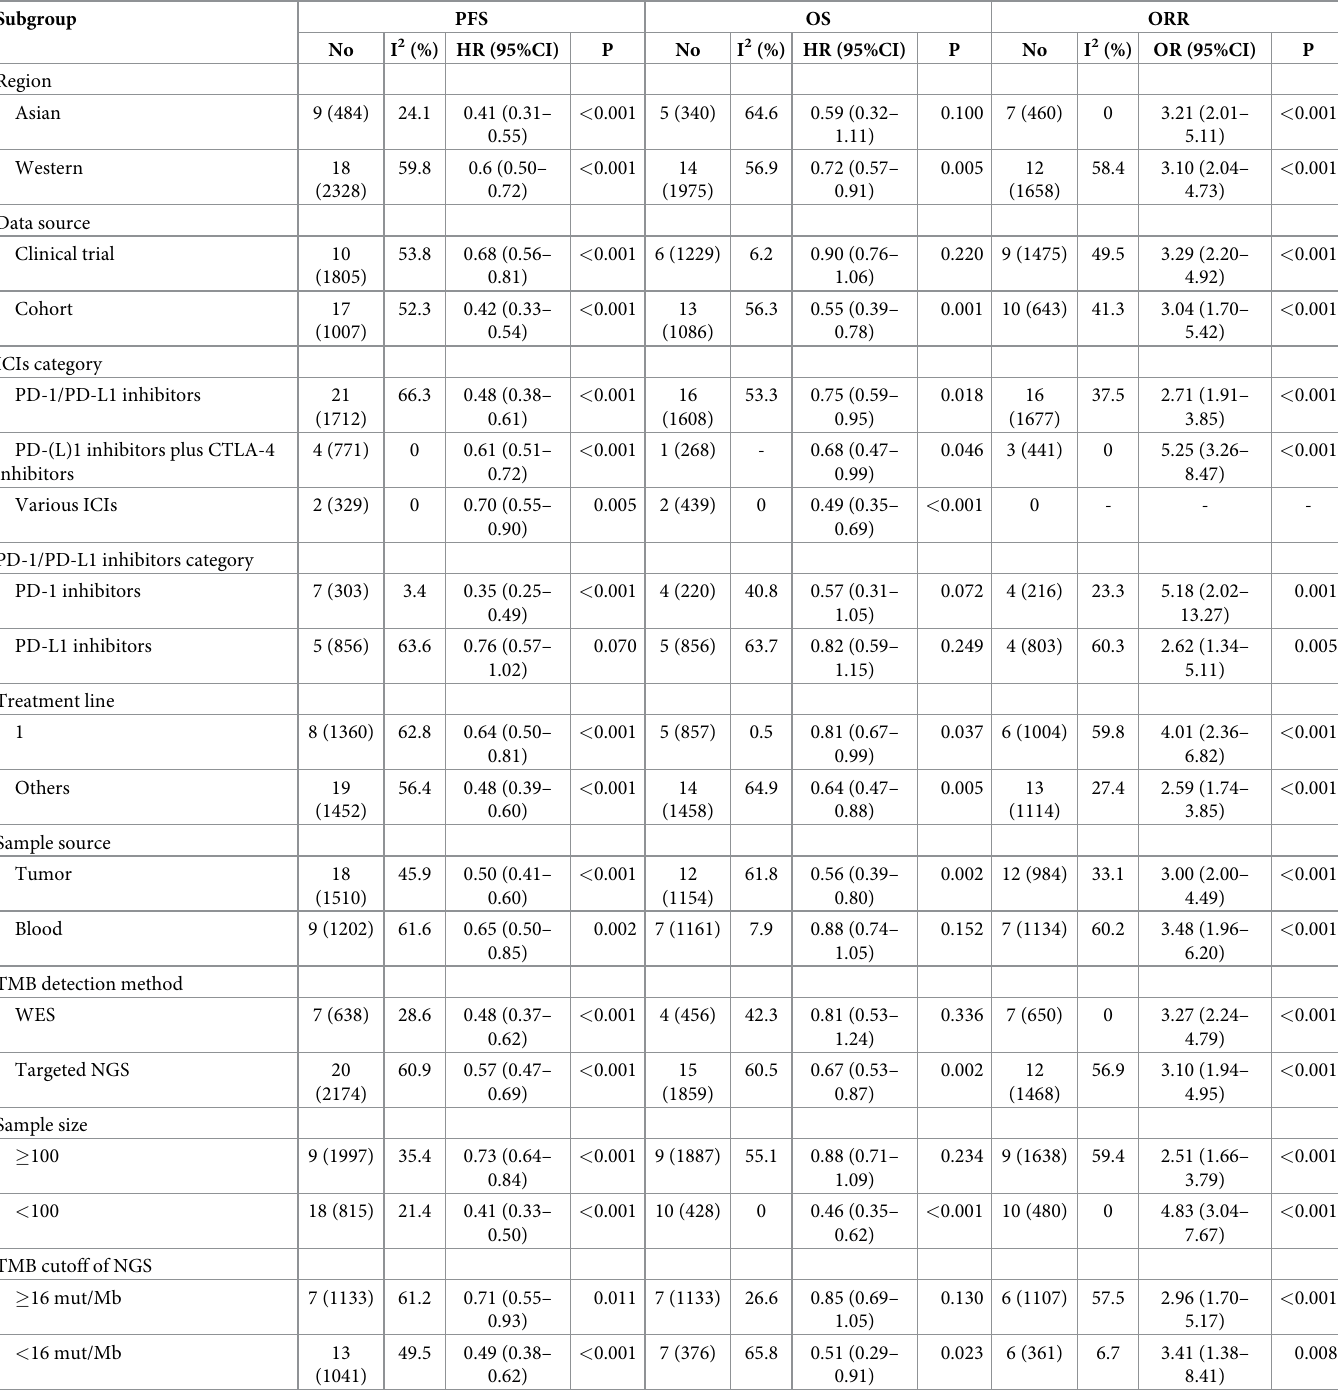
Table 3. Subgroup analysis of immunotherapy efficacy for NSCLC in high TMB group versus low TMB